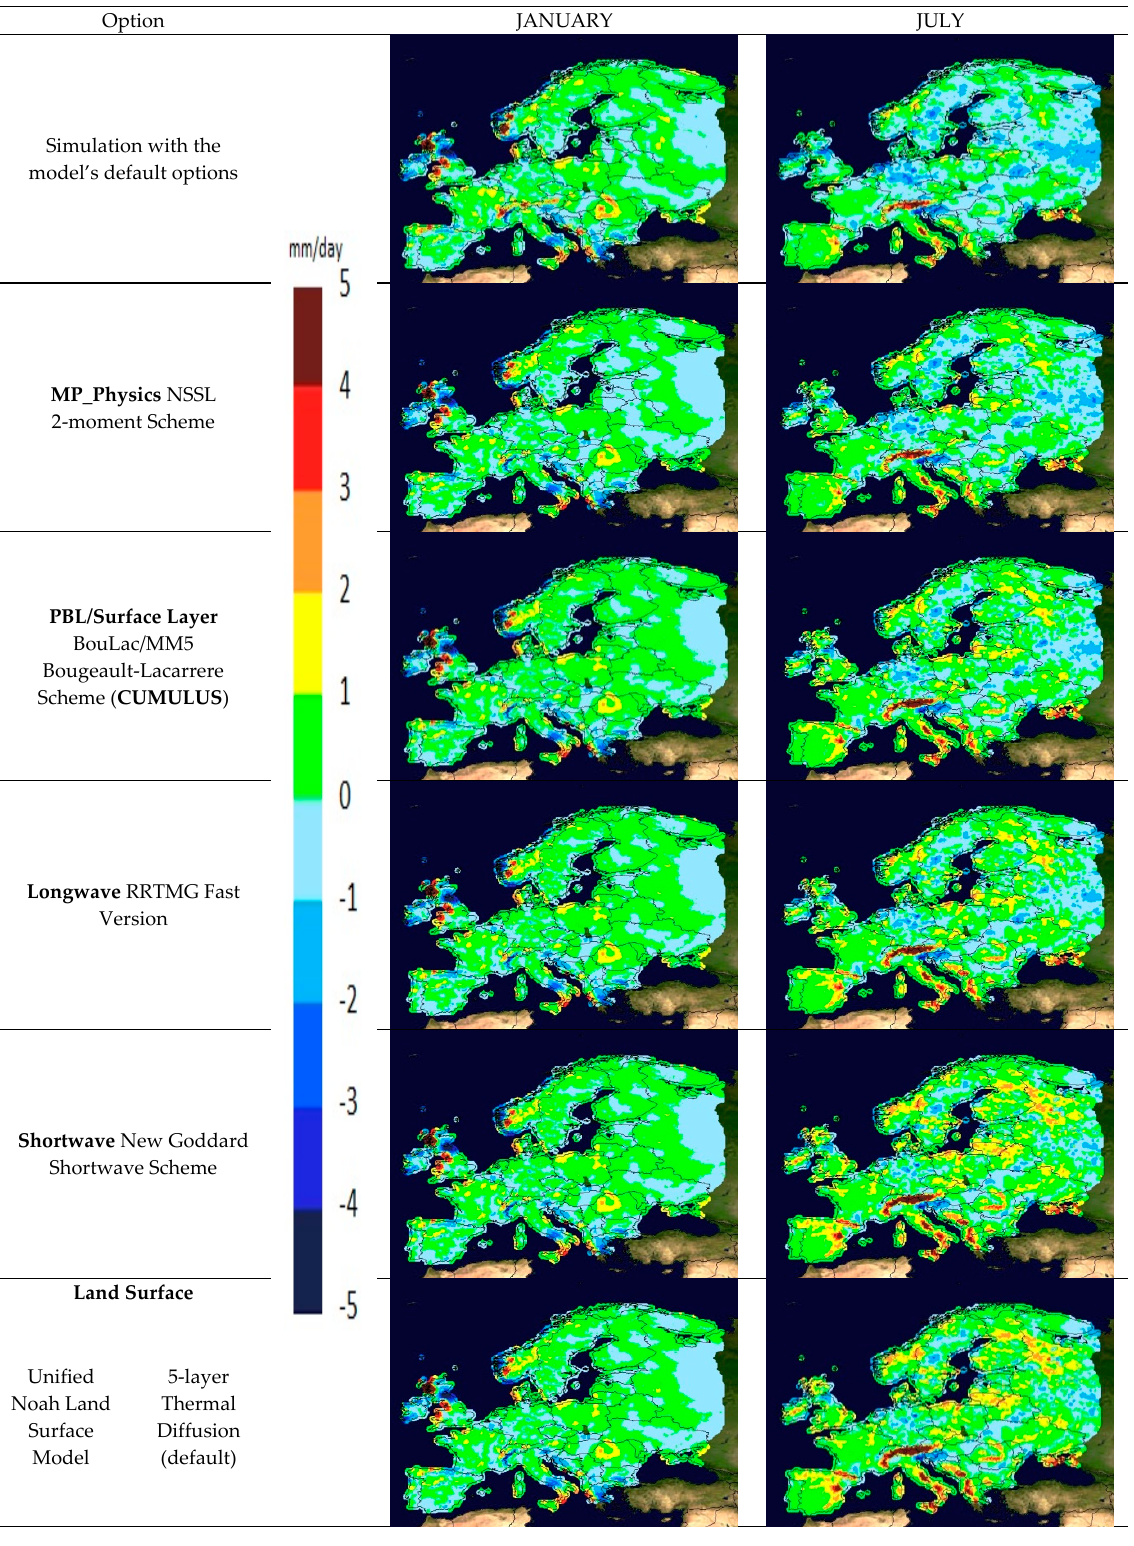
Figure 4. Precipitation Mean Bias spatial distribution after each simulation